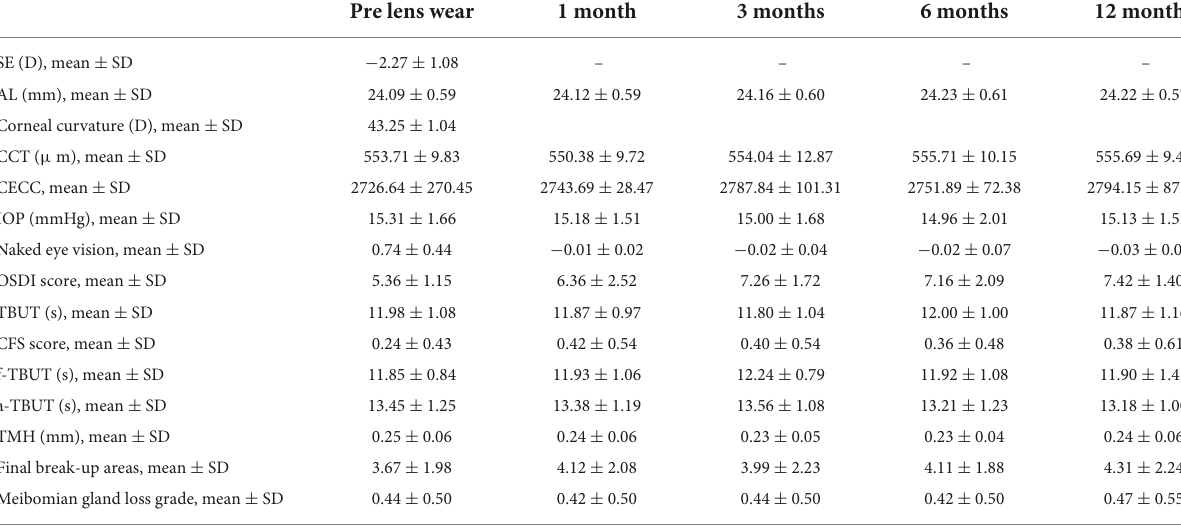
TABLE 3 The baseline ocular parameters and subsequent changes during the follow-up period. Pre lens wear